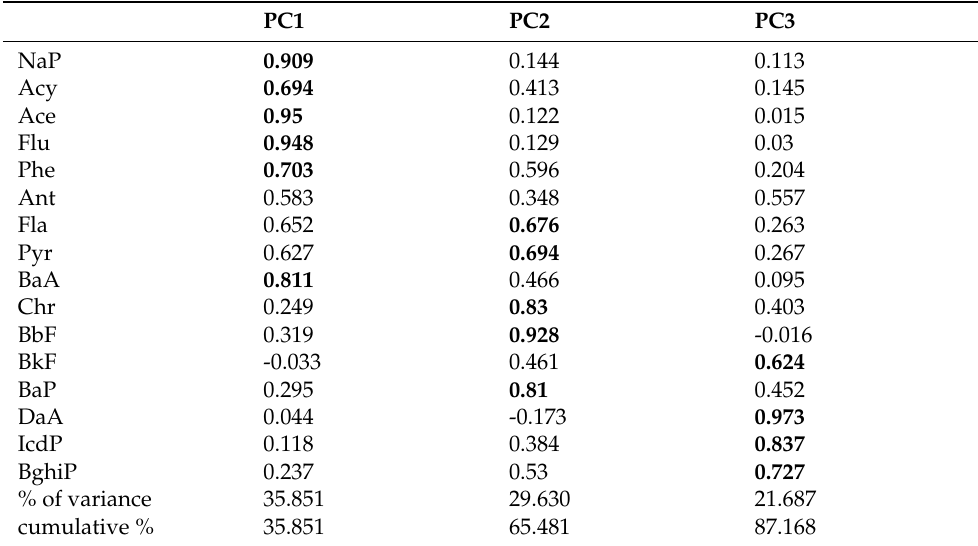
Table 2. Source identi fi cation of PAHs in dustfall by PCA.